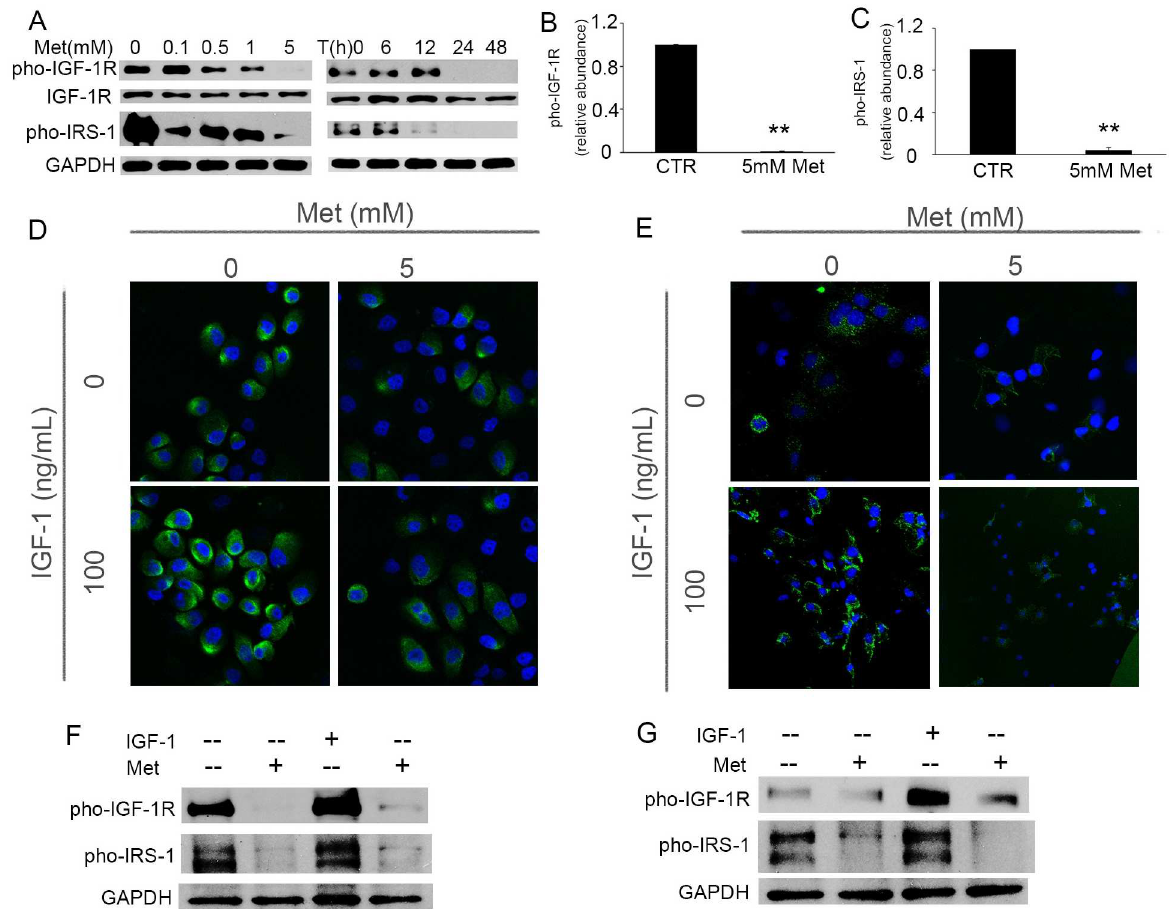
Fig 3. Metformin inhibits expression of IGF-1 receptor(IGF-1R) and abrogates IGF-1-induced phosphorylation of IGF-1R. A: Immunoblotting of IGF-1R, pho-IGF-1R and pho-IRS-1 in proliferating BPH-1 cells treated with various doses of metformin for 24 hours, or with 5 mM metformin for the indicatedtimes. B-C: Quantification of the immunoblot protein expressionof pho-IGF-1R (B) and pho- IRS-1 (C) in BPH-1 cells treated with 5 mM Metformin for 24 hours, and normalized to IGF-1R or GAPDH, respectively. ** , P < 0.001 comparedwith control group. D-E: Representative immunofluorescenceimages of pho-IGF-1R in BPH-1 (D) and P69 (E) cells after exposureto 100 ng/mL IGF-1 in the presenceor absenceof 5 mM metformin for 48 hours. F-G: Immunoblotting of pho-IGF-1R and pho- IRS-1 in BPH-1 (F) and P69 (G) cells 48 hours after treatment of IGF-1(100 ng/mL) and metformin (5 mM). CTR: untreated control, Met: metformin.